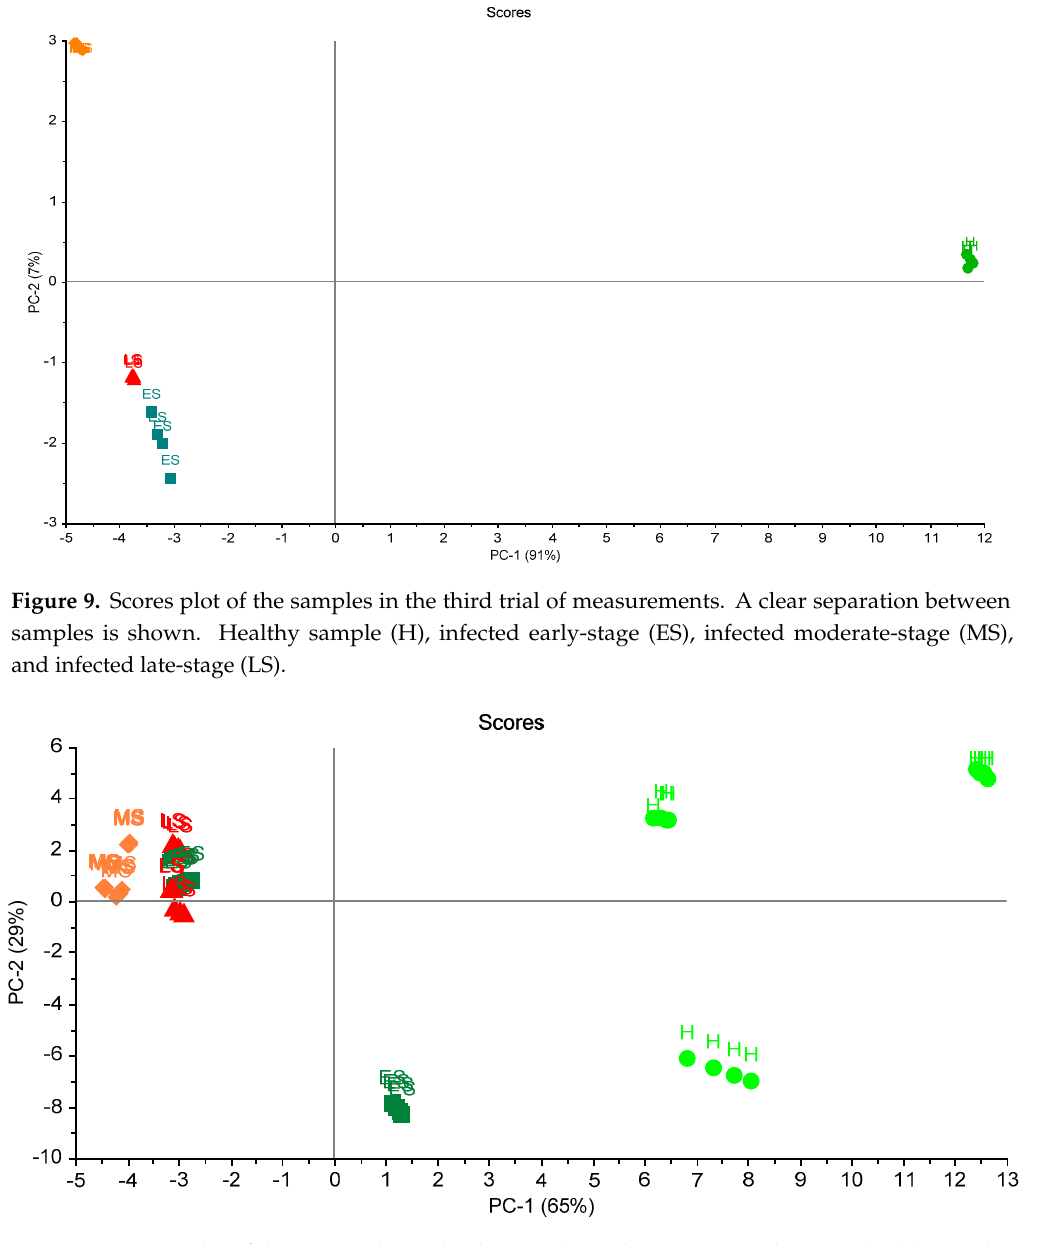
Figure 10. Scores plot of the 16 samples in the three trials. A clear separation between health samples is shown. Healthy sample (H), infected early-stage (ES), infected moderate-stage (MS), and infected late-stage (LS).